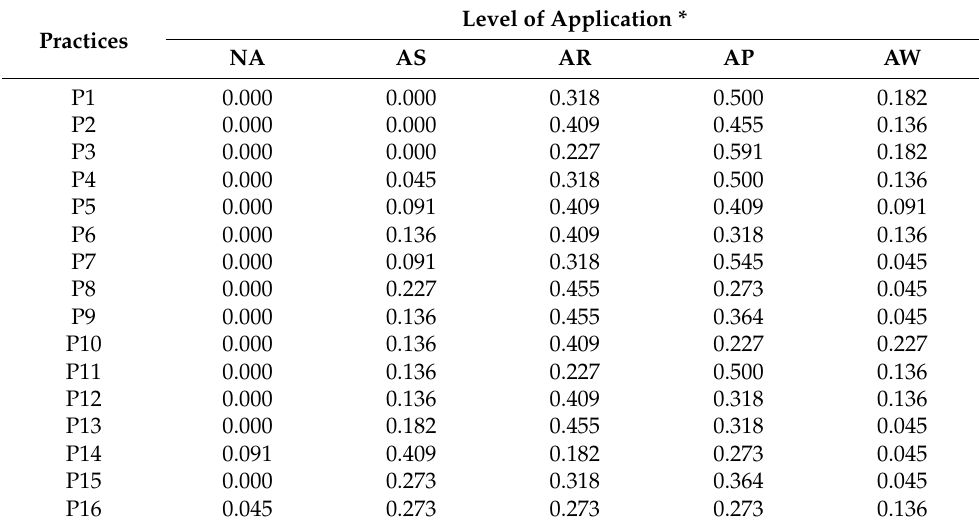
Table 3. Global frequency on the application of each practice in LIs.